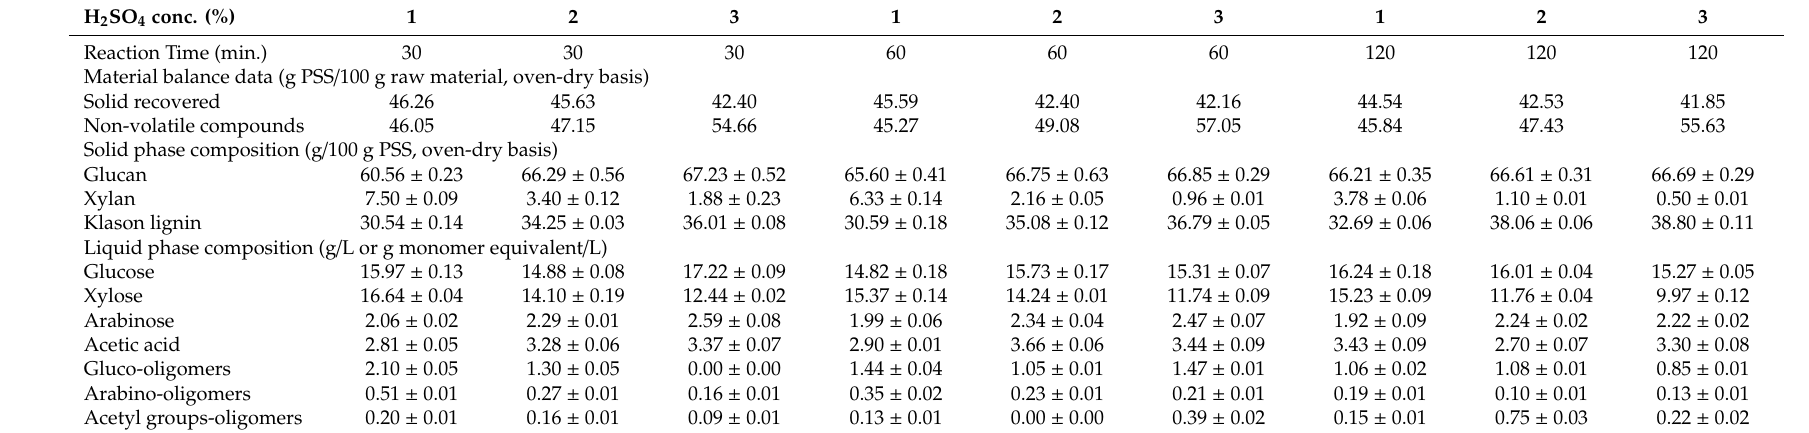
Table 2. Operational conditions employed in SSS dilute acid pretreatment at temperature of 134 ◦ C and experimental results concerning material balances and composition of solid and liquid